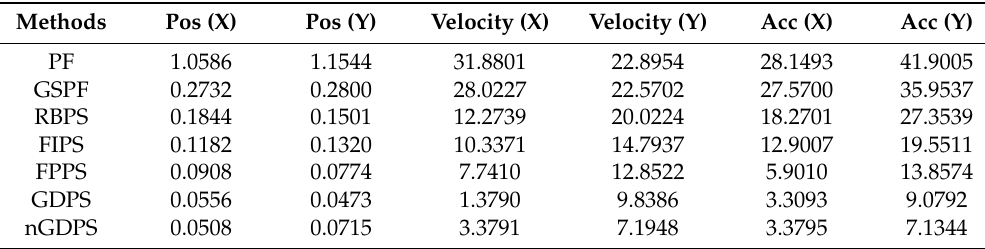
Table 2. RMSEs (m) for the X and Y coordinates averaged over 1000 runs: state errors with respect to the true vehicle state (position, velocity and